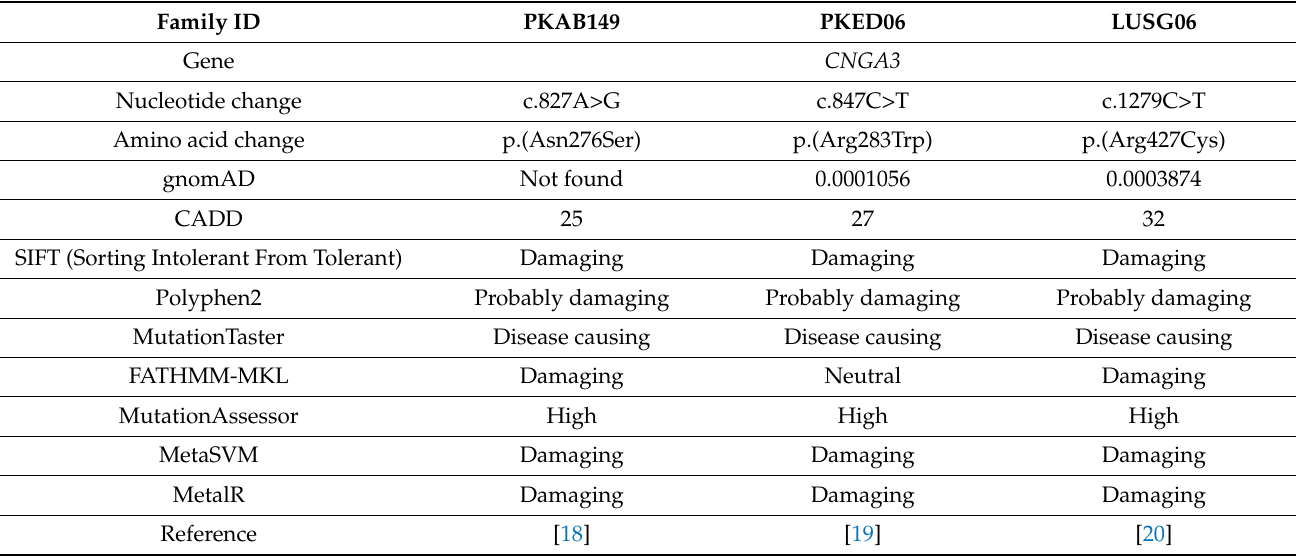
Table 2. Pathogenicity predictions of CNGA3 variants identified in Pakistani